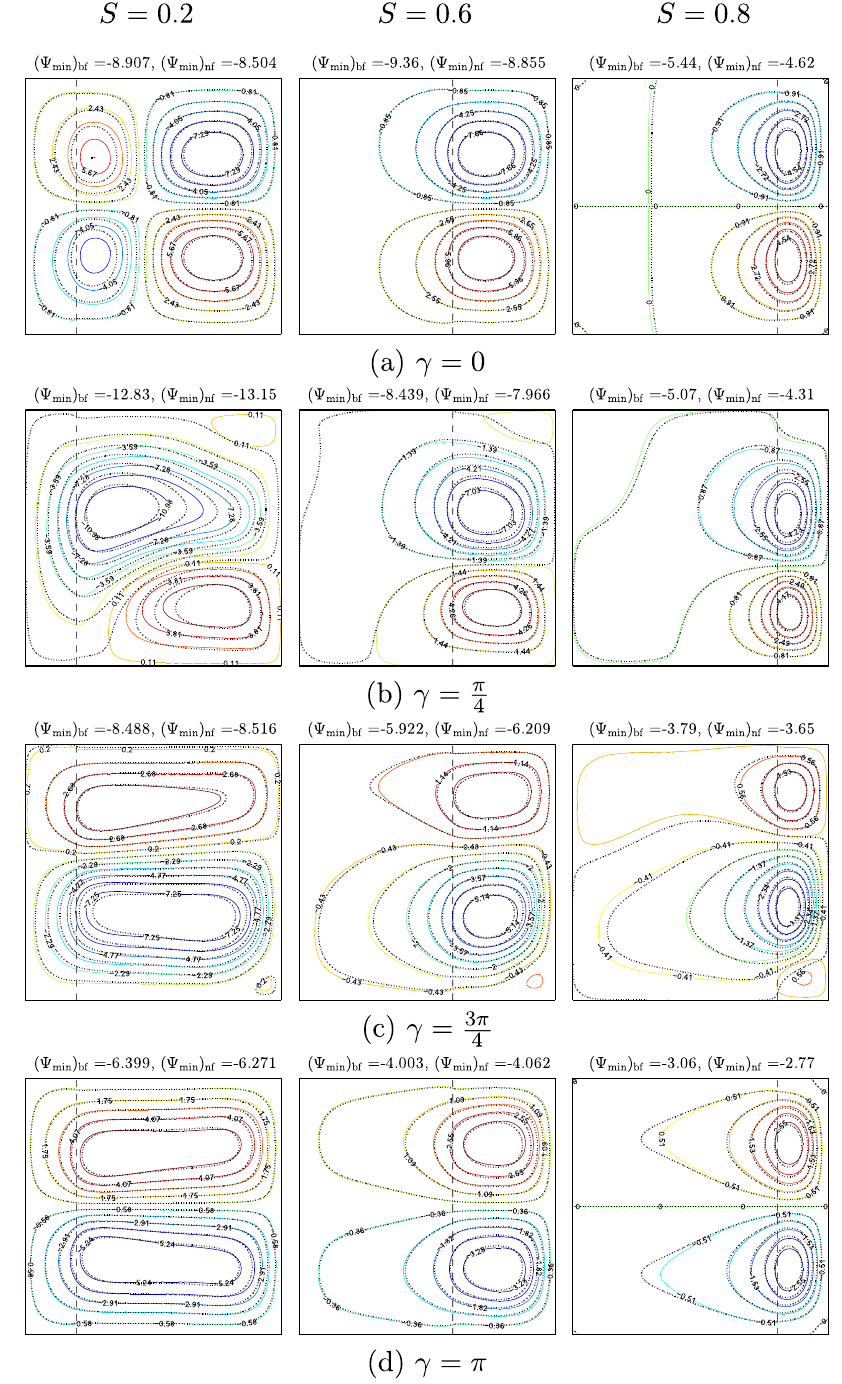
Figure 4. Streamlines evolution by γ and S for Ra bf = 10 5 , Da = 10 − 4 , ε = 1, ϕ = 0°, φ = 0 (solid lines) and φ = 0.1 (dashed